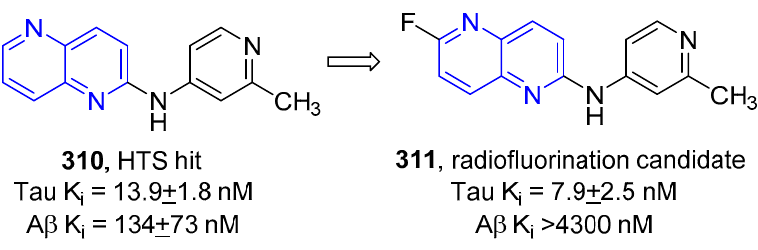
Figure 30. Orexin-1 receptor antagonists.